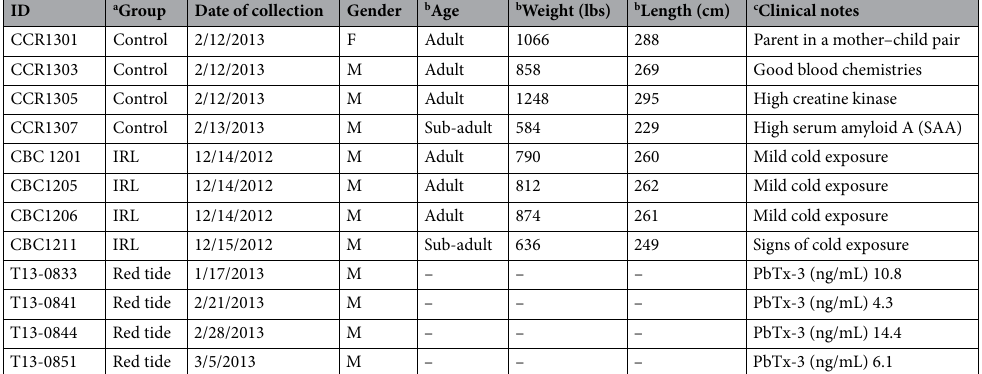
Table 5. Characterization of manatees from which serum samples were drawn. a Group, controls, collected from Crystal River manatees during annual health assessments, IRL, manatees collected from the Indian River Lagoon, Red tide, manatees recovering from red tide at Zoo Florida. b Data on age, weight and length were not available for manatees that recovered at Zoo Florida. c PbTx-3 is the brevetoxin produced during red tide